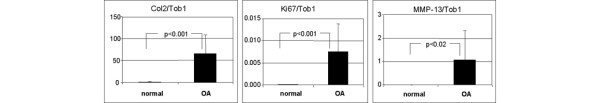
Comparative analysis of mRNA expression levels of collagen type II (Col2), Ki-67, and MMP-13 relative to Tob1 in normal and osteoarthritic chondrocytes.